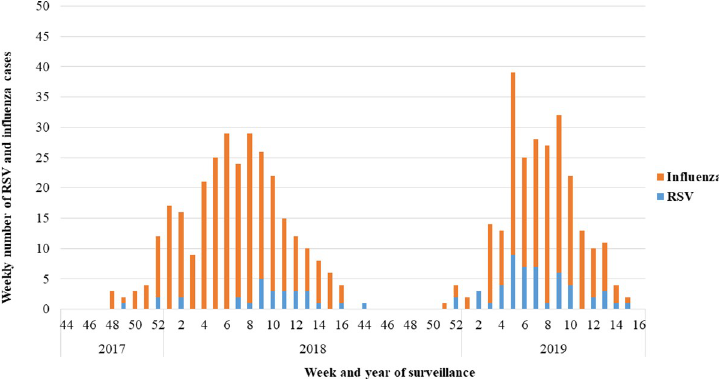
Fig 1. Weekly distribution of confirmed RSV and influenza virus infections 2017–2019. The surveillance started in week 44 in the previous year and ended in week 16 in the following year).